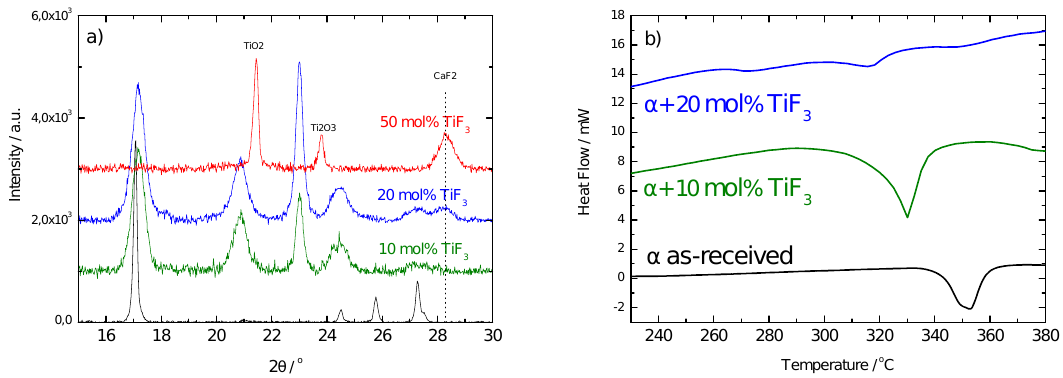
Figure 7. PXD (left-hand panel, ( a )) and DSC (right-hand panel, ( b )) results of ball milled α with 10, 20 and 50 mol% of TiF 3 after 8 h continuous milling. The results for the as-received material are included for